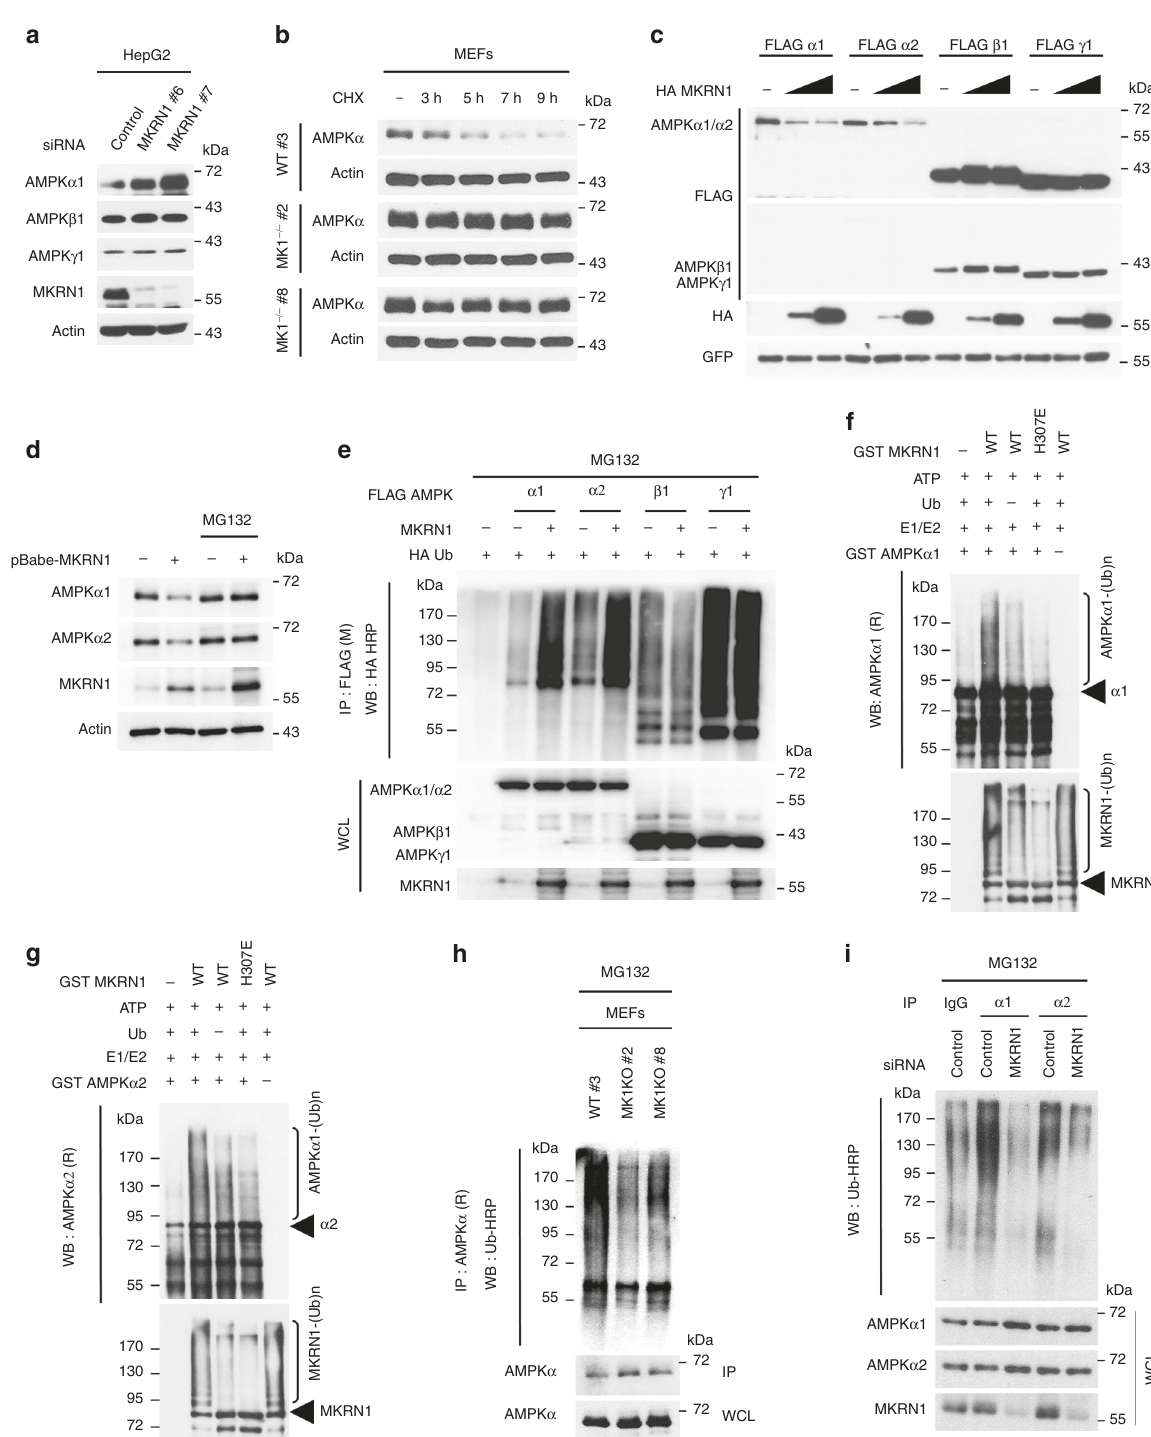
Fig. 2 The E3 ubiquitin ligase MKRN1 ubiquitinates and degrades AMPK α subunits. a MKRN1 knockdown increases AMPK α 1 protein levels. The HepG2 cells were transfected with MKRN1 siRNAs (#6 and #7). b MKRN1 knockout stabilises AMPK α . WT or MK1 − / − MEFs were treated with CHX (100 mg ml − 1 ) at the indicated time points. c , d MKRN1 expression promotes the proteasomal degradation of AMPK α subunits. The protein levels